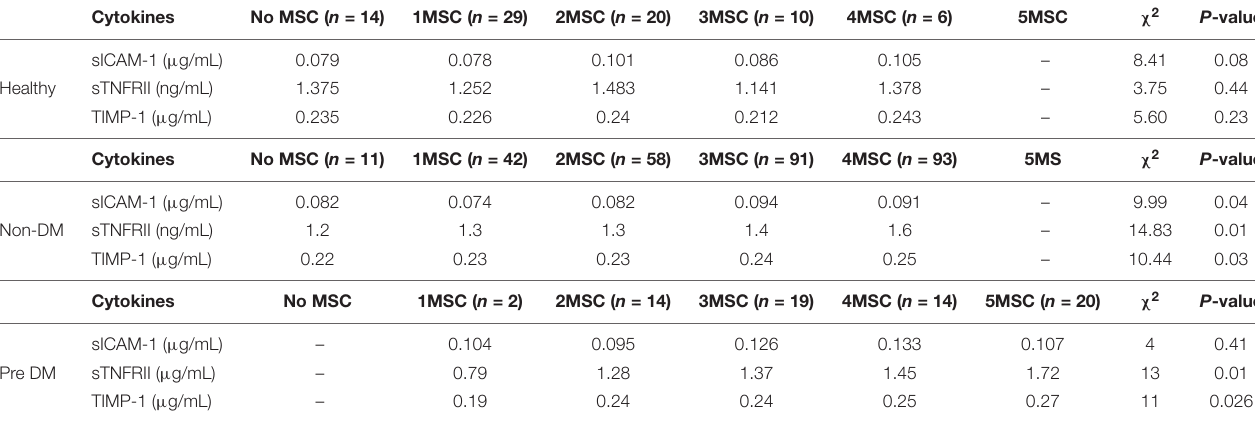
TABLE 3 | Inflammatory profile in components of metabolic syndrome. Cytokines